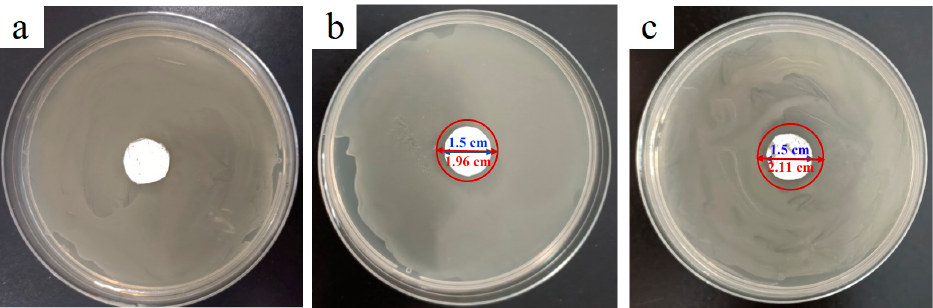
Figure 5. The inhibition zone of nano fi bers (PCL@PN ( a ), PN@6 wt%Ag-2 h ( b ), and PN@8 wt%Ag-2 h ( c )) on Staphylococcus aureus after 24 h.